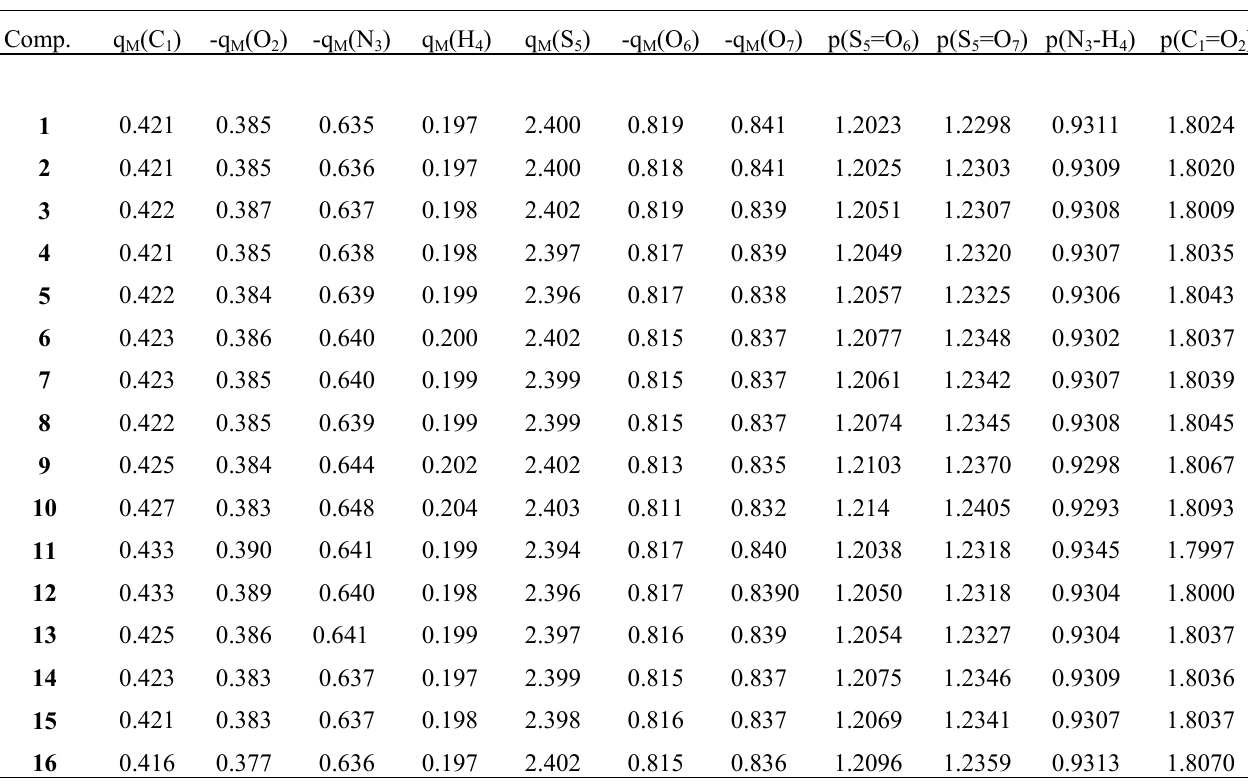
Table 2. Calculated PM3 Mulliken charges and bond orders for substituted N -phenyl- sulfonylbenzamides 1 – 16